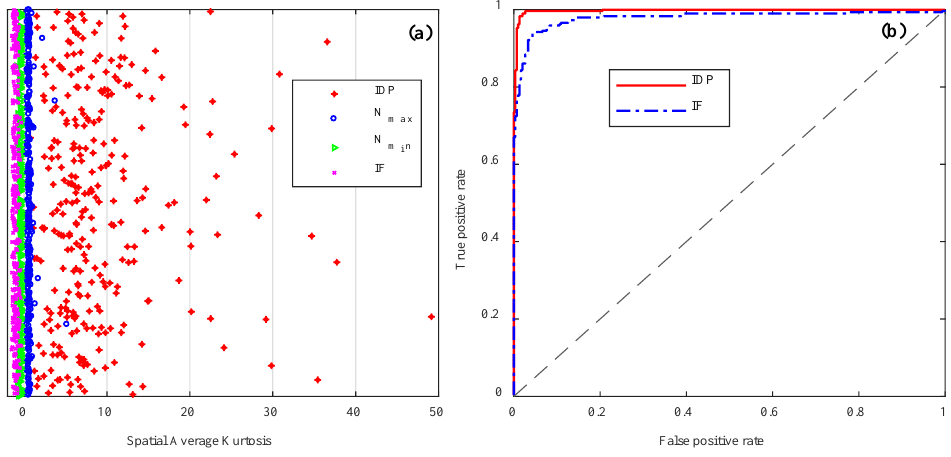
Figure 12. The statistic results of perturbation discrimination by SAK method. ( a ) The SAK distribution of different types of signals; ( b ) The receiver operating characteristic (ROC) curves of perturbation discrimination. IDP: instantaneous destructive perturbations; IF: interference.